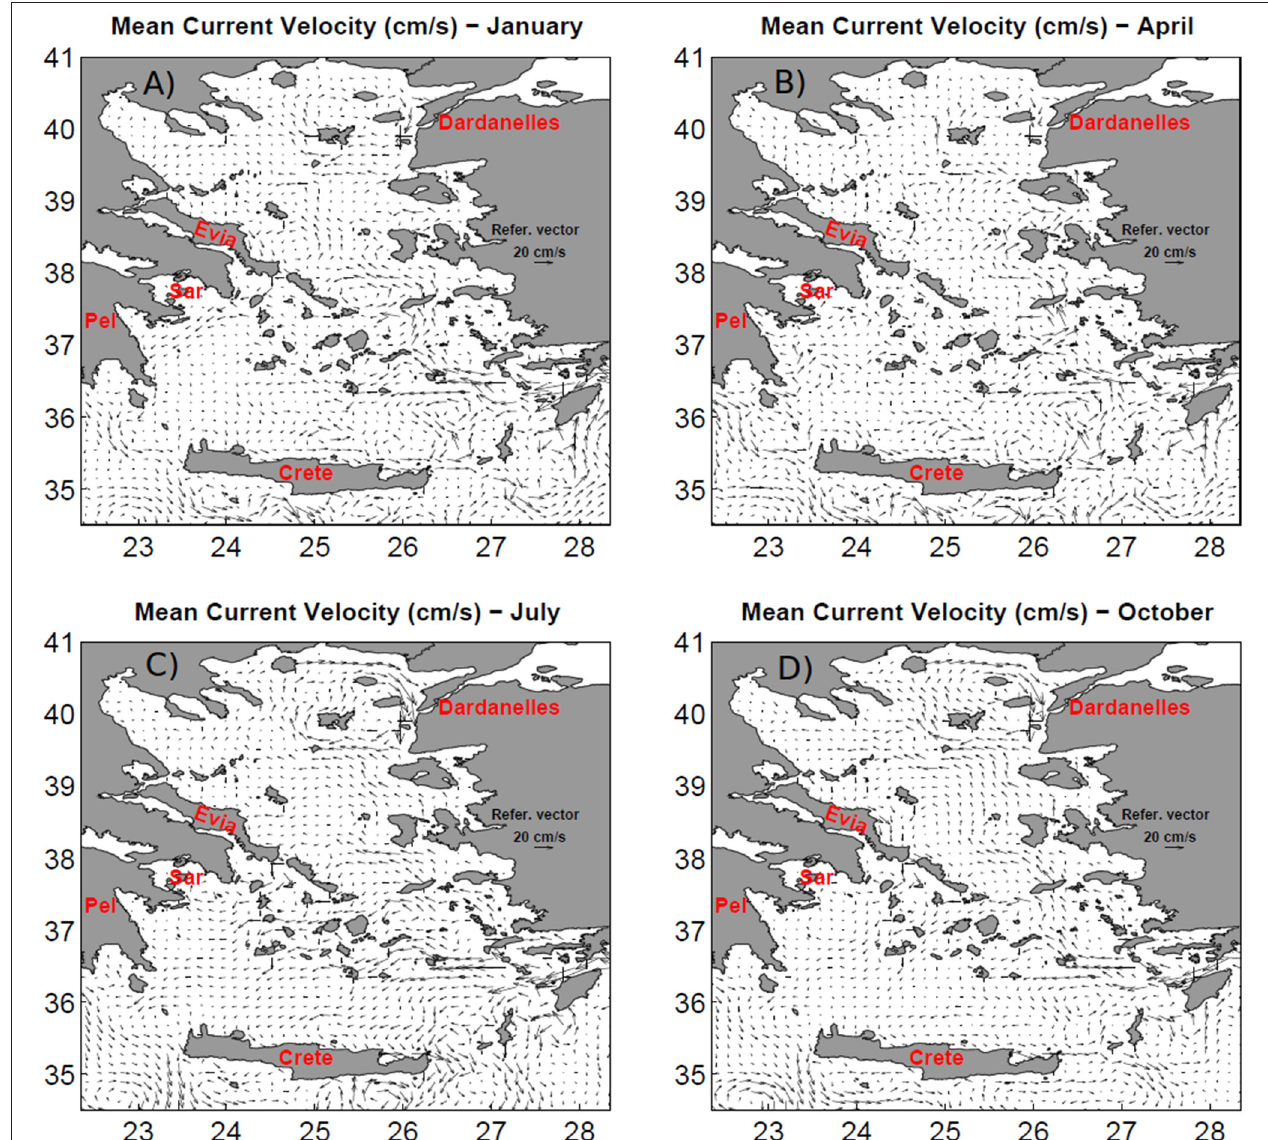
and the areas outside the Saronikos and Thermaikos Gulf ( Figure 5O ). High values in standard deviation map of